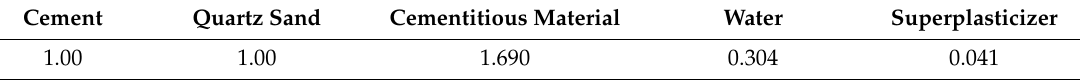
Table 1. Mix proportion of the ultra-high performance concrete (UHPC; mass).